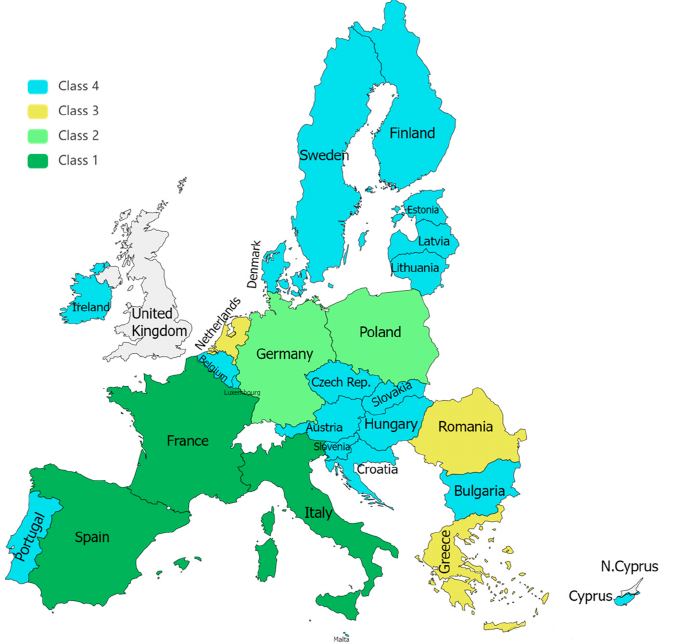
Figure 11. Graphic representation of the distribution for the clusters generated by hierarchical cluster analysis. Source: Authors’ calculation and representation, according to Eurostat (2020) data.